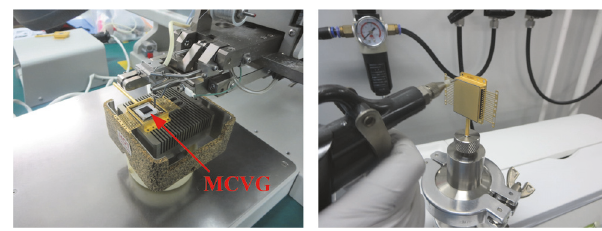
Figure 12: MCVG on the packaging platform.